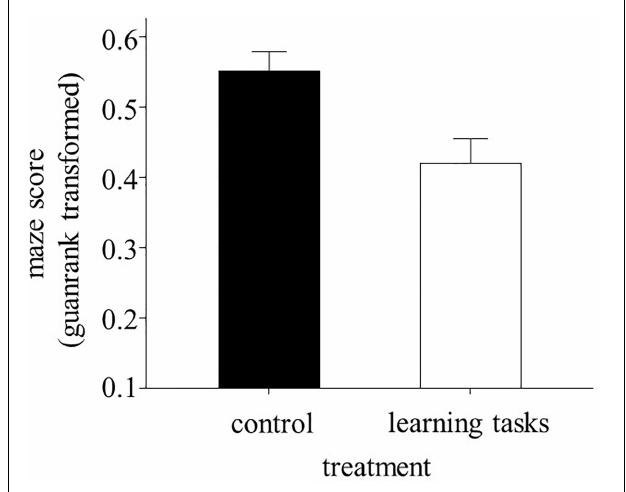
FIGURE 1 | Mean ± S.E. maze scores (GuanRank-transformed time taken to cross the maze test) performed by juvenile sticklebacks after the 2-month experimental treatment (learning task group, n = 64; control group, n = 112). A higher maze score indicates a shorter time to reach the food rewards.